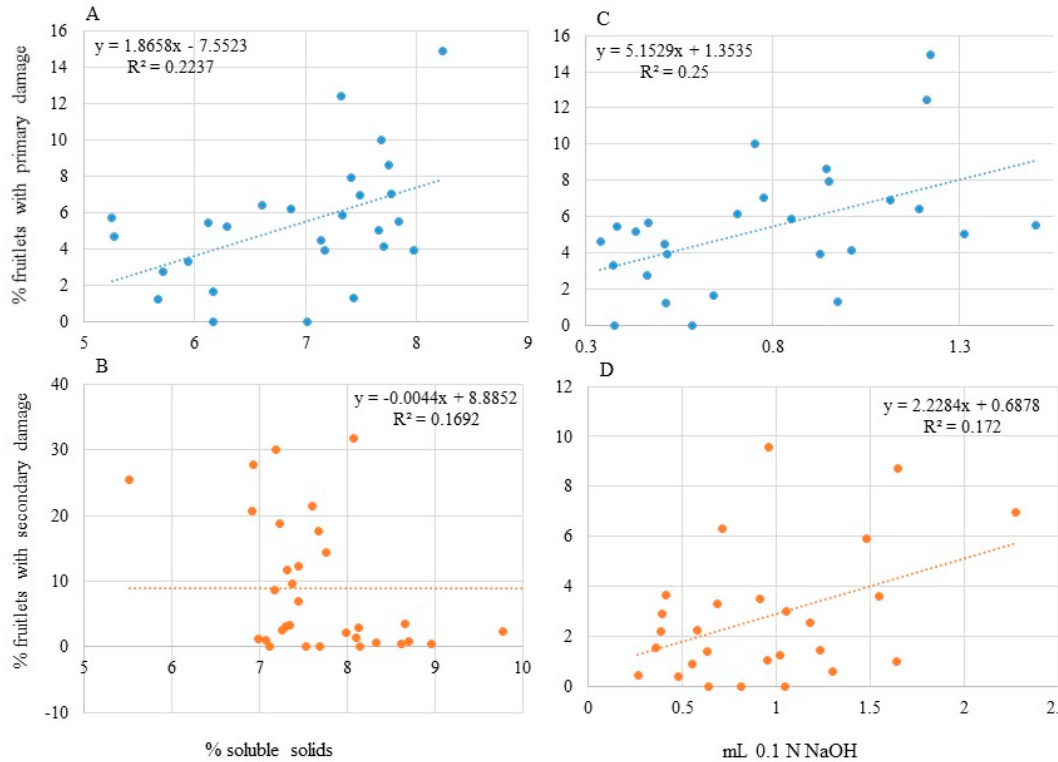
Figure 4. Mean percentage of fruitlets showing: ( A ) primary damage as correlated with soluble solids from fruitlets 10 mm in size, ( B ) secondary damage as correlated with soluble solids from fruitlets 30 mm in size, ( C ) primary damage as correlated with mL of 0.1 N NaOH (acidity) from fruitlets 10 mm in size and ( D ) secondary damage as correlated with change in acidity of fruitlets during development from 10 to 20 mm in size.